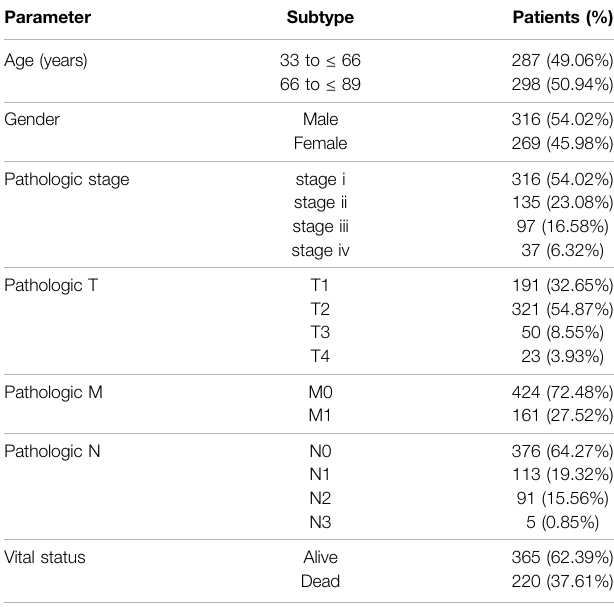
TABLE 1 | Clinical pathological characteristics of 585 patients with lung adenocarcinoma.